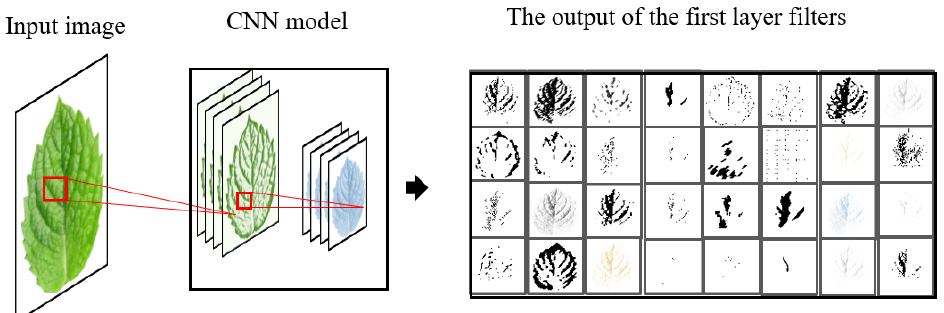
Figure 8. The first activation layer of each channel related to the test images.